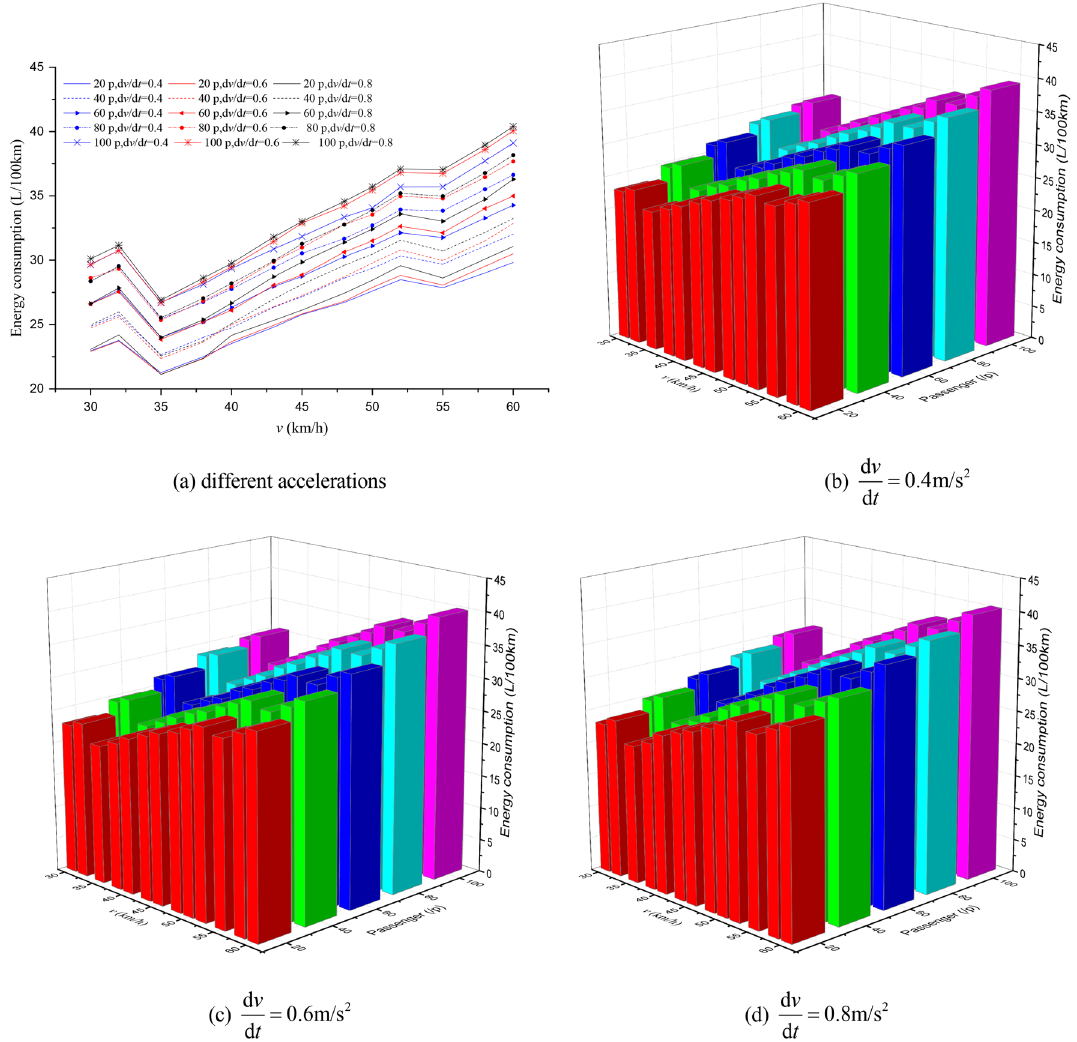
Figure 10. The EC of different passenger load, acceleration and maximum speed for 1000 m station